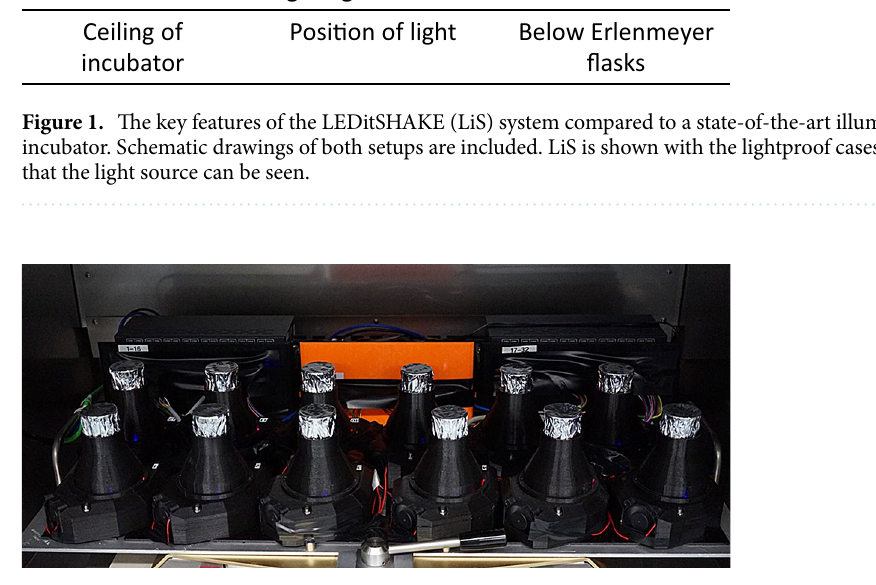
Figure 2. The LiS system equipped with 12 Erlenmeyer flasks in a shaking incubator. The 12 individual LiS vessels are shown in the foreground. The three boxes in the background contain dimmer controls connected to the LEDs and